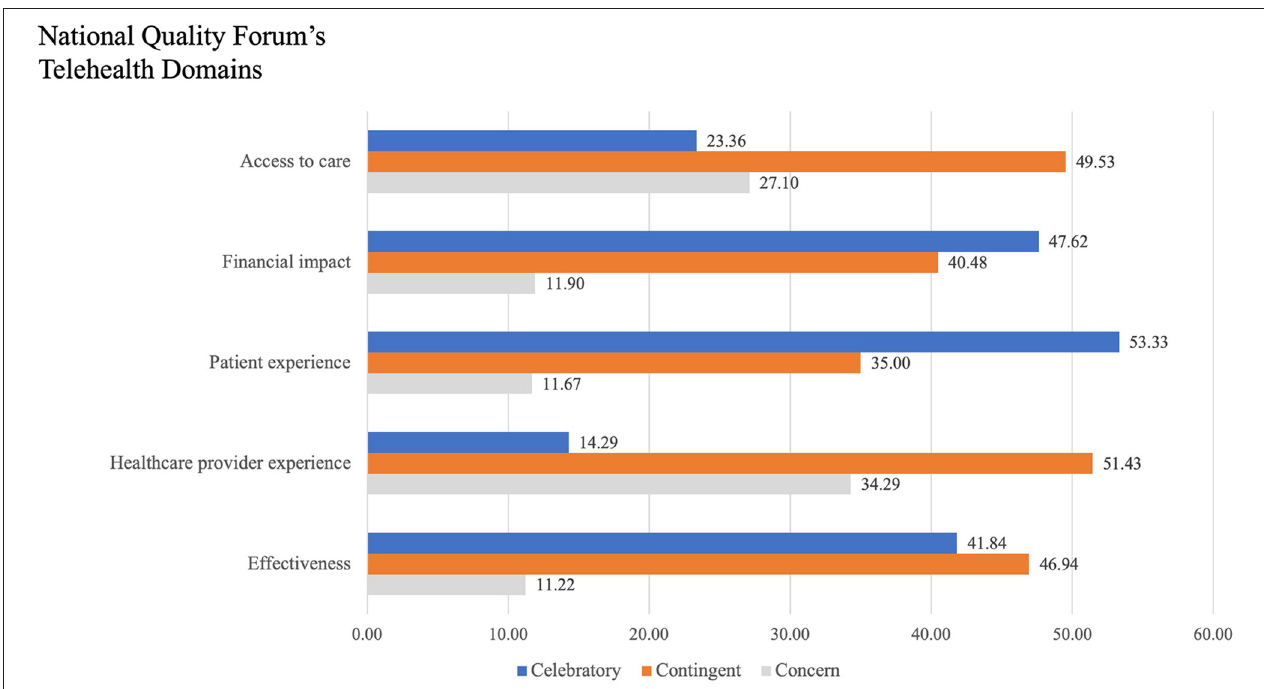
FIGURE 2 | Sentiment analysis of author outlook on NQF domains.